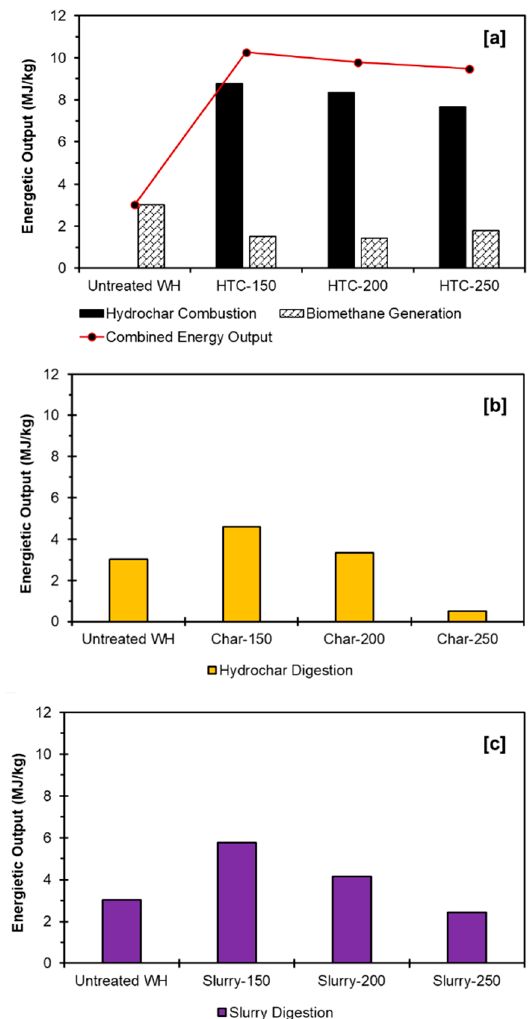
Figure 5. Energetic output from each hydrothermal carbonisation (HTC) and anaerobic digestion (AD) integration strategy, using a starting material of 1 kg of dried water hyacinth (WH). Integration strategies include ( a ) combustion of hydrochar and digestion of process waters ( b ) digestion of hydrochars only ( c ) digestion of slurries. HTC-150 = HTC of WH at 150 ◦ C and separation of hydrochar and process water. HTC-200 = HTC of WH at 200 ◦ C and separation of hydrochar and process water. PW-250 = HTC of WH at 250 ◦ C and separation of hydrochar and process water. Char-150 = hydrochar produced from WH at 150 ◦ C. Char-200 = hydrochar produced from WH at 200 ◦ C. Char-250 = hydrochar produced from WH at 250 ◦ C. Slurry-150 = HTC slurry produced from WH at 150 ◦ C. Slurry-200 = HTC slurry produced from WH at 200 ◦ C. Slurry-250 = HTC slurry produced from WH at 250 ◦